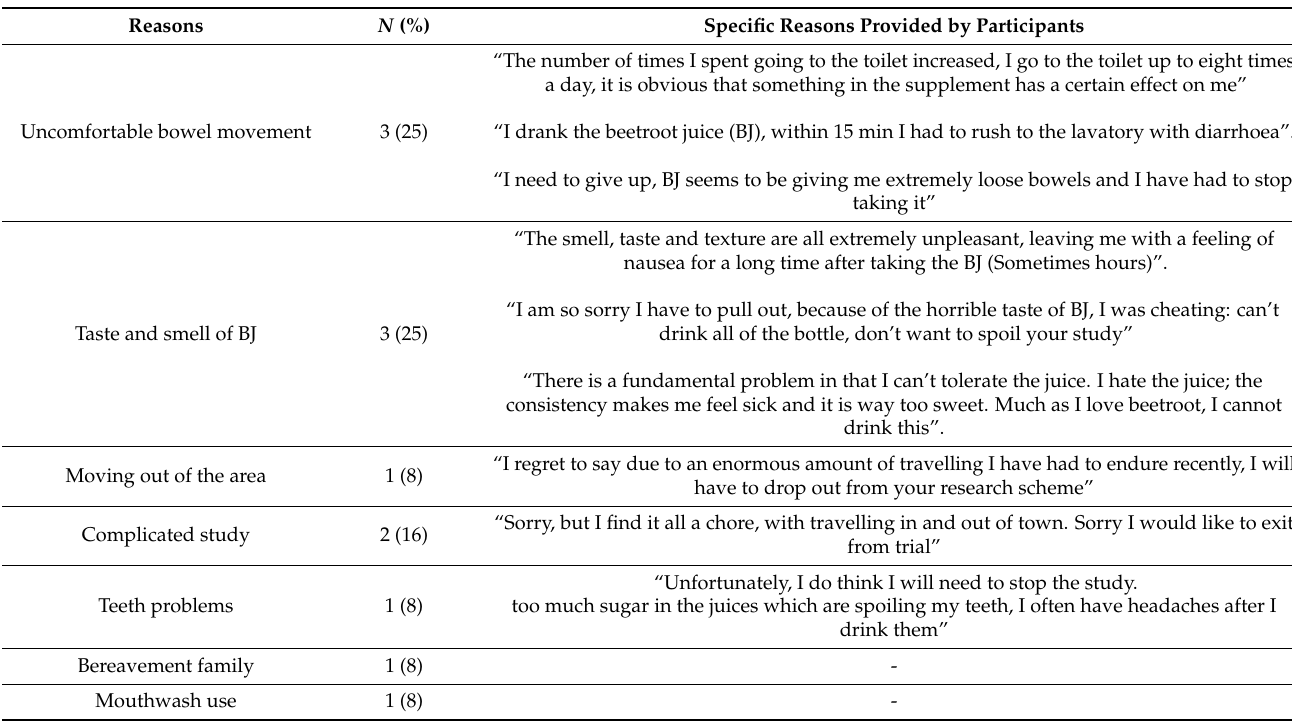
Figure 2. Flowchart of participants recruited into the feasibility study. Table 2. Primary reasons for withdrawal from